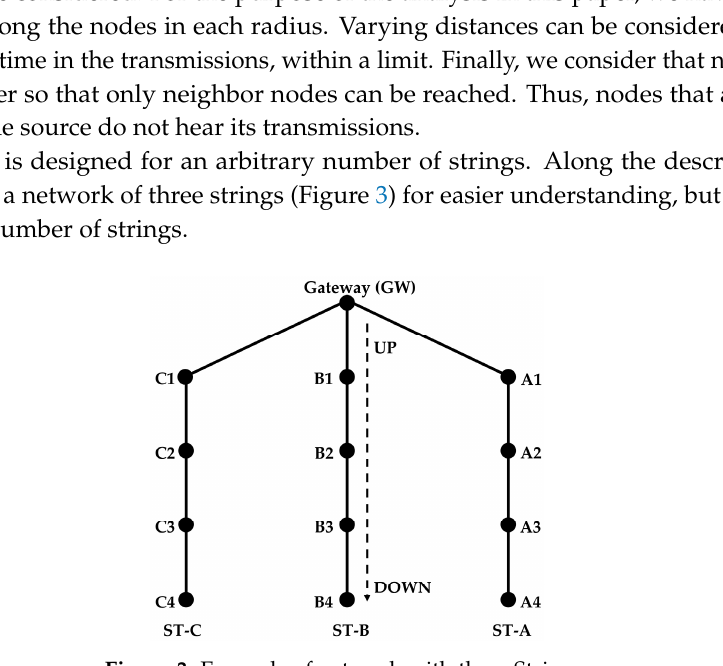
Figure 3. Example of network with three Strings.